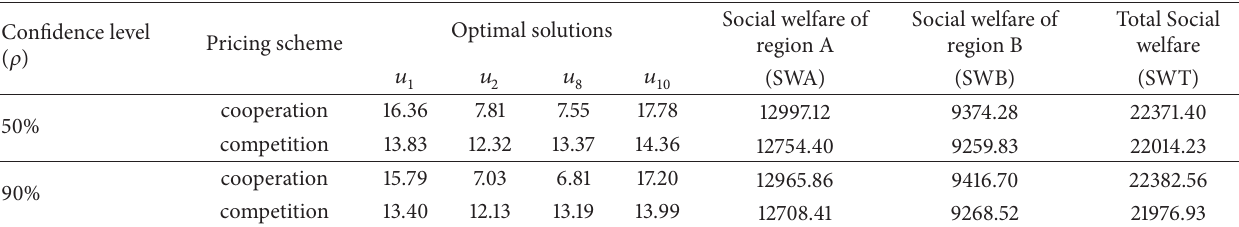
Table 3: Pricing results for cooperative and competitive